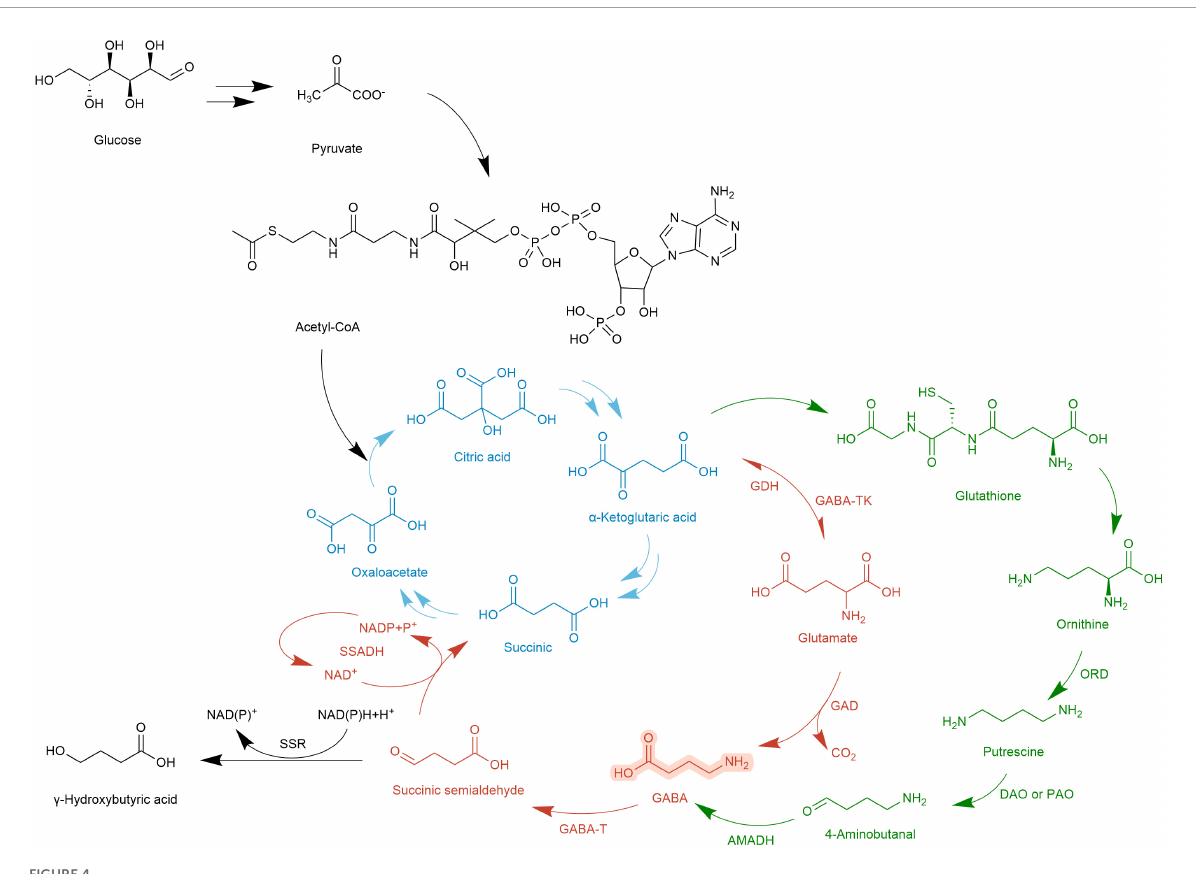
FIGURE4 Metabolic map of GABA synthesis and GABA degradation. , TCA cycle; , GABA shunt; , PA pathway; ,